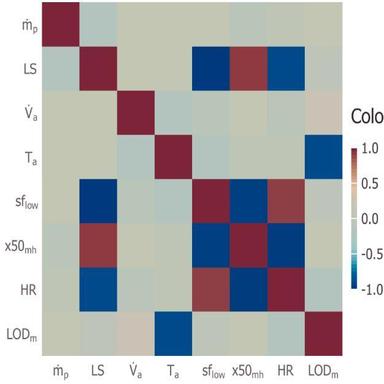
Pearson correlation matrix for selected process parameters and material properties. x50,mh indicates the x50 value of the mid and high fractions of the sieved granules.